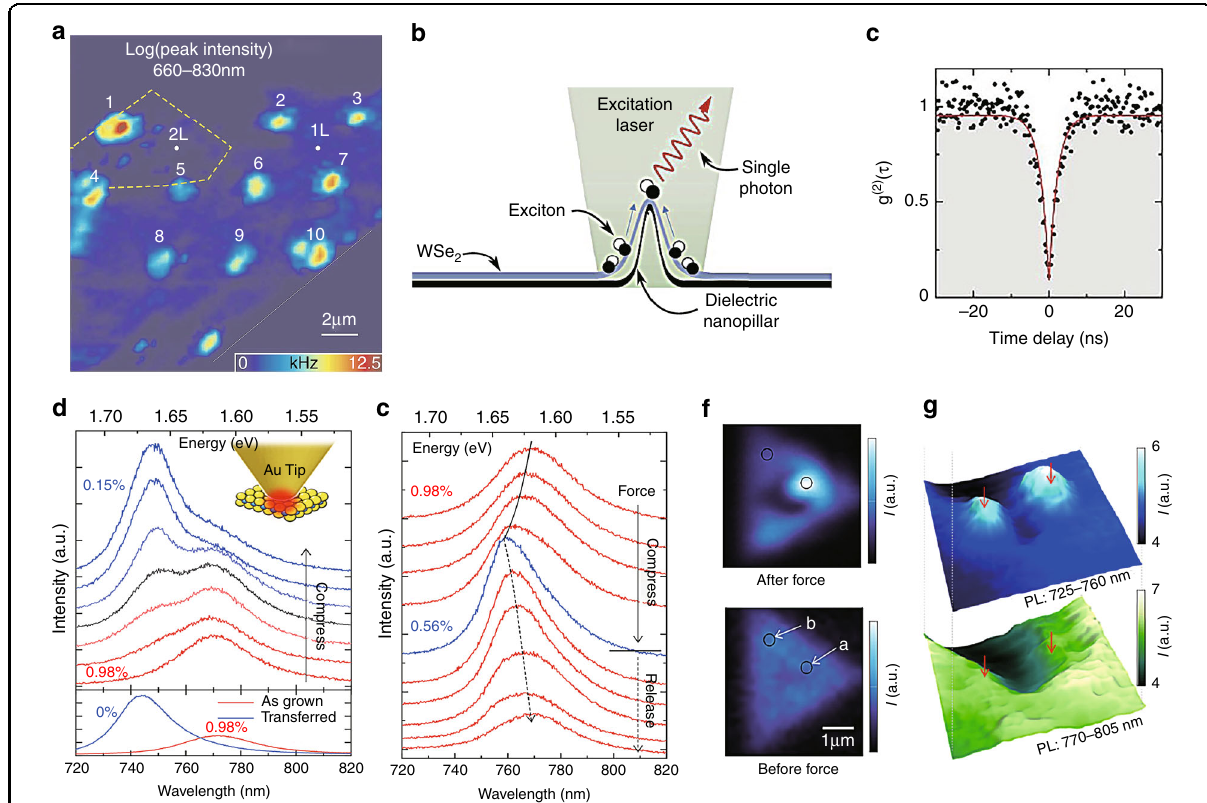
Fig. 11 Strained TMDC-based single-photon emitters and high-resolution nanoimaging. a PL map of locally strained monolayer WSe 2127 . b Schematic of the scheme to realize a strain-induced quantum emitter through local deformation atomically thin WSe 2 by a nanopillar to achieve a point-like elastic strain perturbation 127 . c Second-order photon correlation statistics from a single quantum emitter in a , revealing evident antibunching [ g (2) (0) = 0.07 ± 0.04 and τ = 2.8 ± 0.2 ns] 127 . d Irreversible evolution of the TEPL spectra of an as-grown WSe 2 monolayer with built-in tensile strain (upper panel) and PL spectra for the as-grown (red), and transferred strain-relaxed (blue) WSe 2 monolayers (lower panel) 140 . e Reversible evolution of the TEPL spectra of the as-grown monolayer WSe 2 (ref. 140 ), and f confocal PL images of the sample before and after applying a force. “ a ” denotes an irreversible area and “ b ” denotes a reversible area 140 . g Blueshifted TEPL (725 – 760 nm) and main TEPL (770 − 805 nm) images of two strain- released areas in a WSe 2 fl ake near nucleation sites 140 . Reprinted a – c with permission from ref. 127 . Copyright (2017) Springer Nature. Adapted d – g with permission from ref. 140 . Copyright (2016) American Chemical